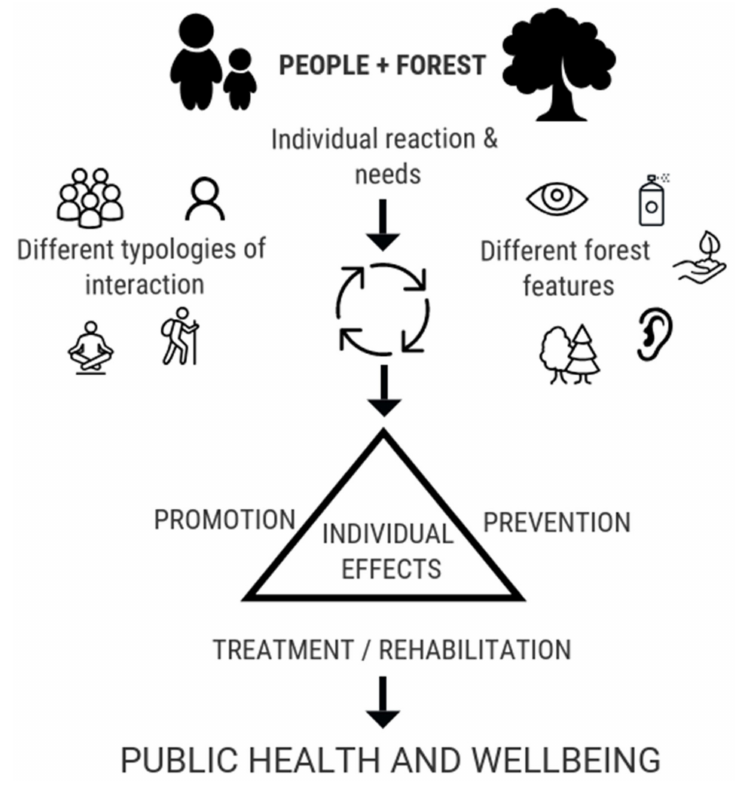
Figure 4. Pathways from forest experiences to public health and